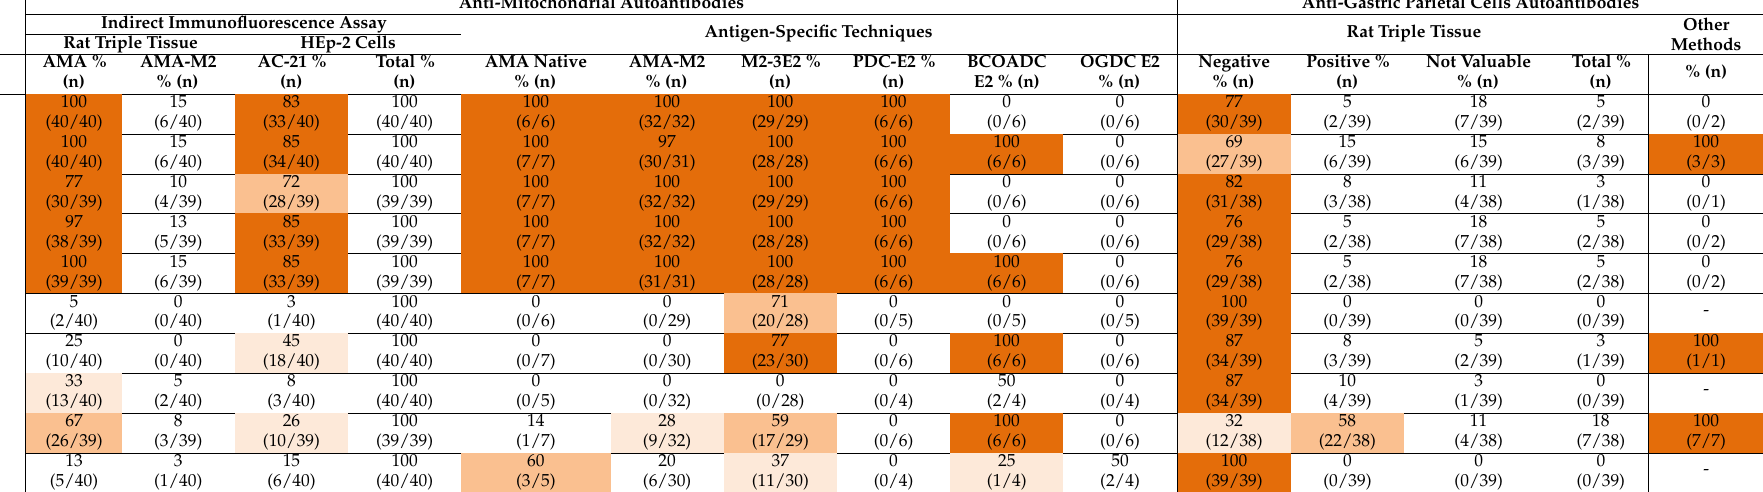
Table 3. Description of AMA results in PBC, pre-PBC and PBC/AIH-1 overlap